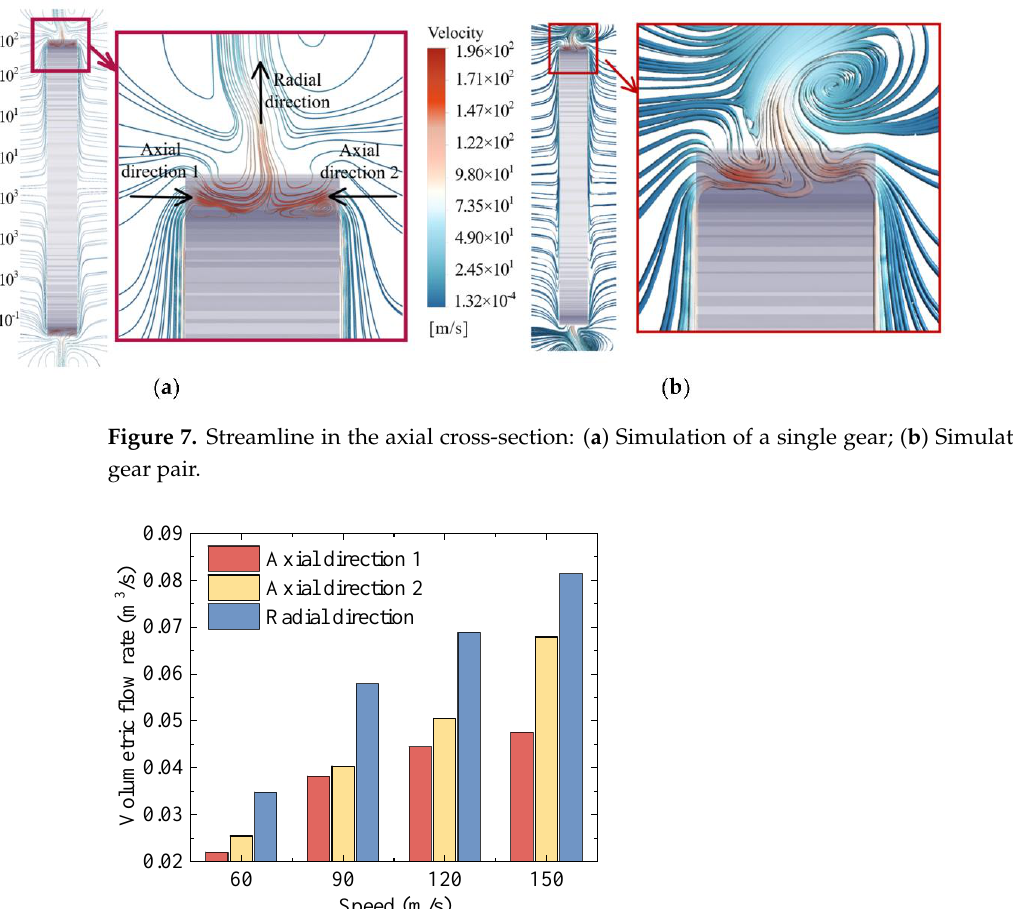
Figure 8. Volumetric flow rate drawn or expelled between the teeth in the simulation of a single gear.